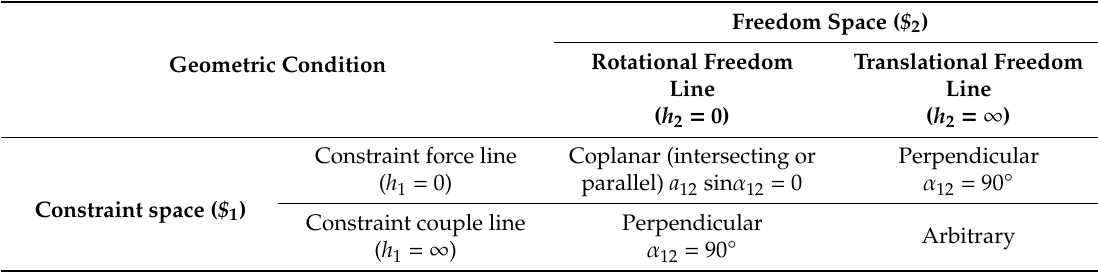
Table 3. Geometric relationship between the freedom and constraint